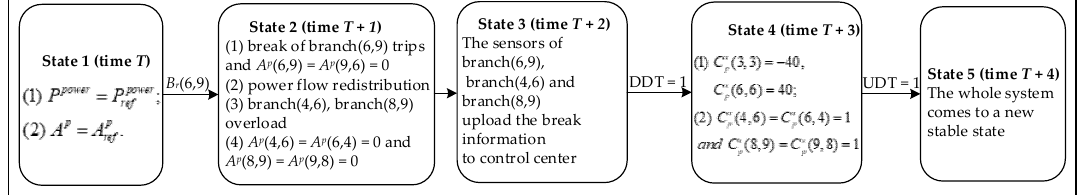
Figure 3. State machine of branch fault state of cyber–physical power systems (CPPS). power P and p A represent power flow and topology information when ref ref